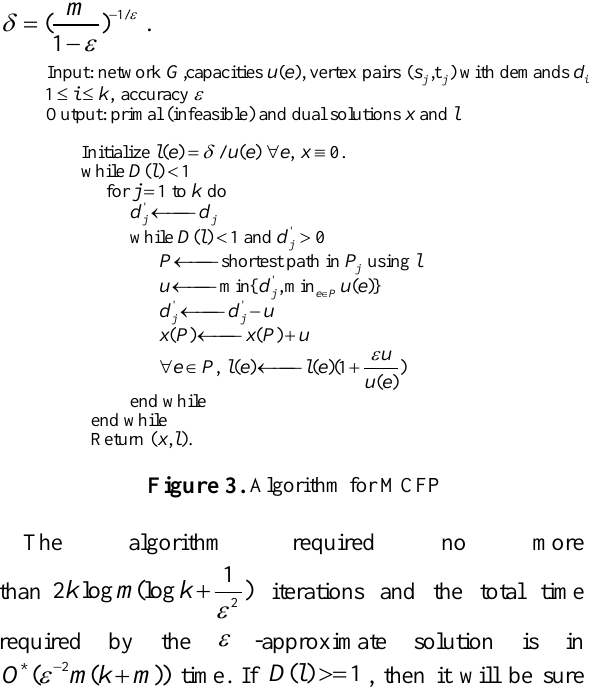
Figure 3. Algorithm for